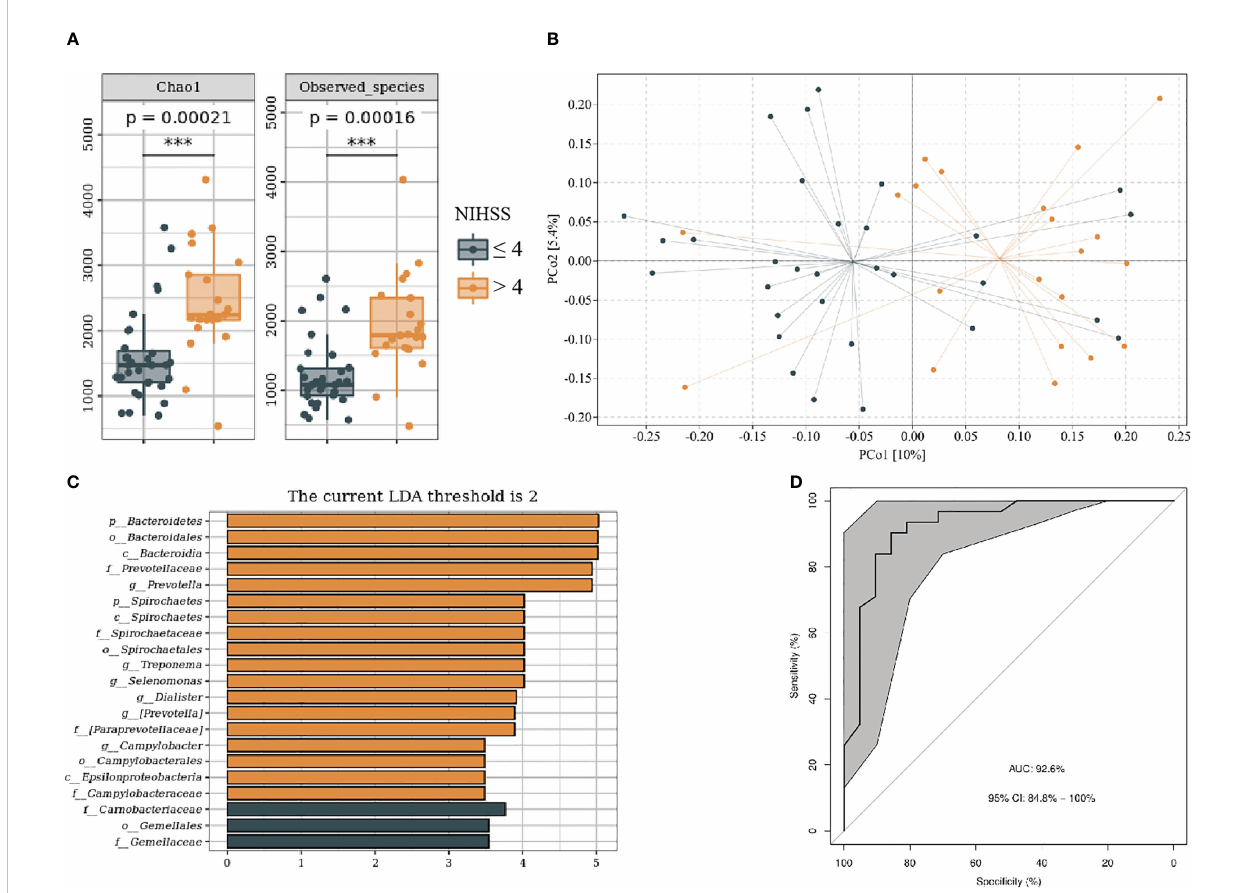
FIGURE 5 Oral microbiota composition of patients with NIHSS ≤ 4 and NIHSS > 4. (A) Comparison of a -diversity between the oral microbiota in two groups. (B) Principal coordinate analysis based on the unweighted UniFrac distances. (C) linear discriminant analysis effect size-determined differential features. (D) Machine learning for classi fi cation based on oral microbiota using the random forest algorithm. ***: P value ≤